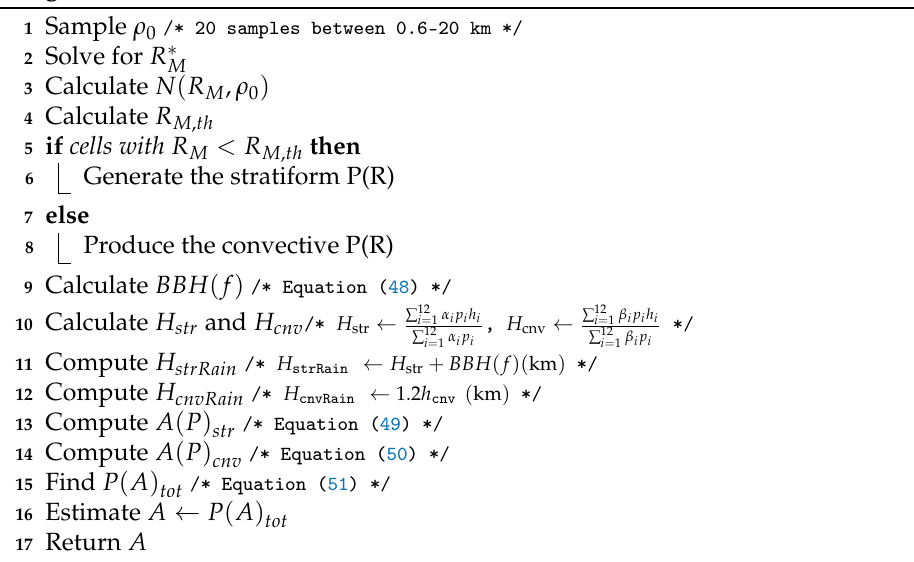
Algorithm 18: SCEXCELL Model